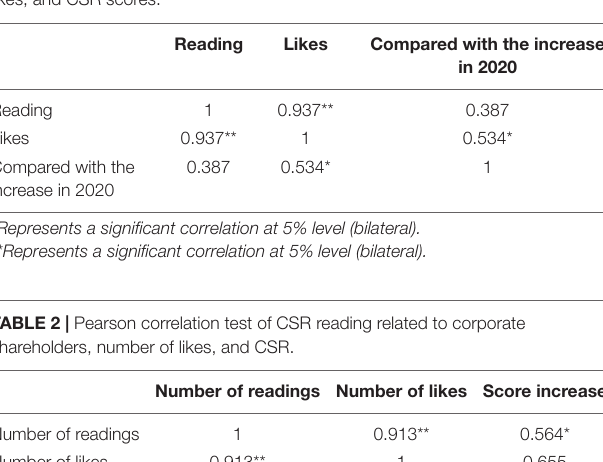
TABLE 1 | Pearson correlation test of potential customers’ readings, likes, and CSR scores.